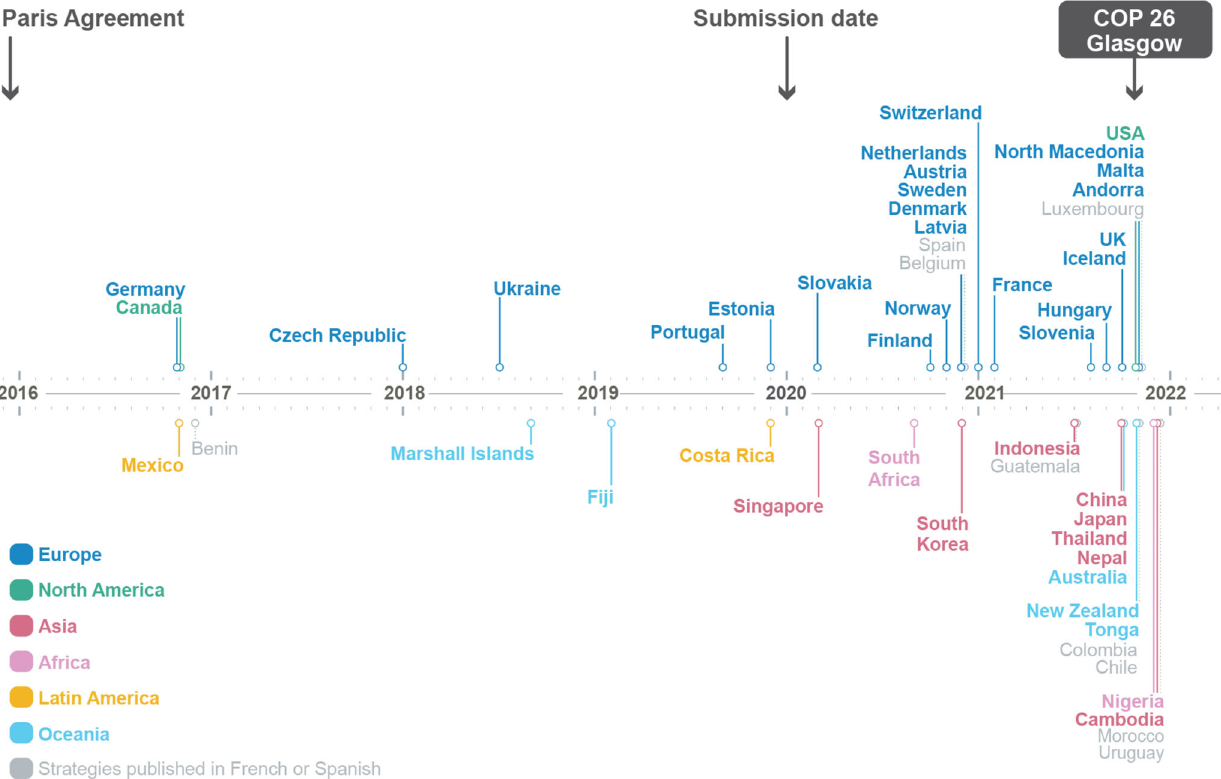
Fig. 1 Timeline of submissions of Long-term national climate strategies to the UNFCCC Secretariat or European Commission, categorised by region. Regions based upon the United Nations M49 standard ‘ Standard Country or Area Codes for Statistical Use ’ for region or sub-region. Dates are publication by the UNFCCC Secretariat, except for Estonia which is the date of submission to the European Commission. Strategies published in French or Spanish which were not analysed, are shown in grey. ‘ COP 26 ’ refers to the 26th Conference of the Parties to the United Nations Framework Convention on Climate Change (UNFCCC), held in Glasgow, United Kingdom. ‘ Submission date ’ refers to the submission period detailed in Decision 1/CP.21, paragraph 35. ‘ Paris Agreement ’ refers to the date of adoption, the agreement later entered into force in November 2016. Omitted are the publication dates for strategies made obsolete by the publication of a more recent strategy by the same country. This applies to the USA (previous strategy: November 2016), France (previous strategy: December 2016), the UK (previous strategy: April 2018) and Japan (previous strategy: June